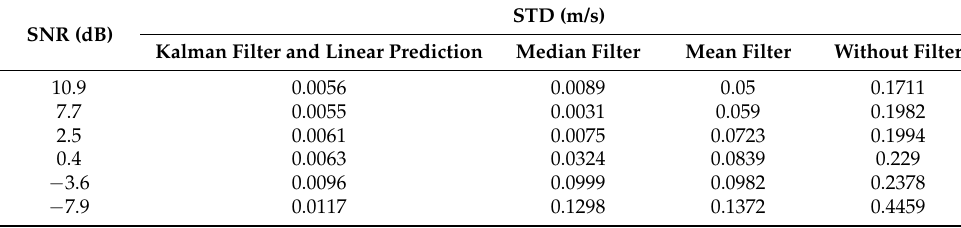
Figure 8. Velocity measured by CHDSF using the Kalman filter and linear prediction method, median filter and mean filter in different SNRs: ( a ) SNR = −3 .6 dB; ( b ) SNR = 7.7 dB.